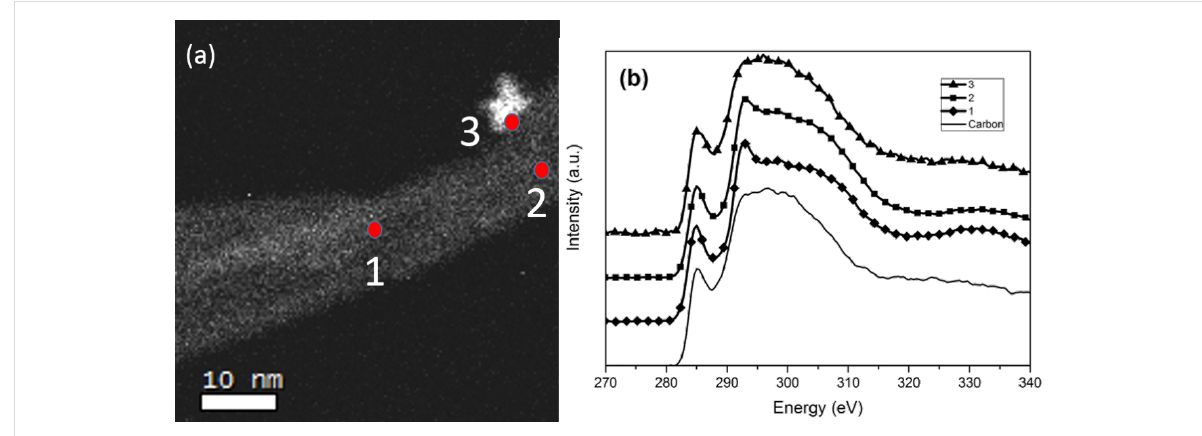
Figure 4: (a) HAADF-STEM image of the area of interest where EELS was performed, (b) C K-edge core loss EELS spectra on the area of interest in- dicated in Figure 2a.